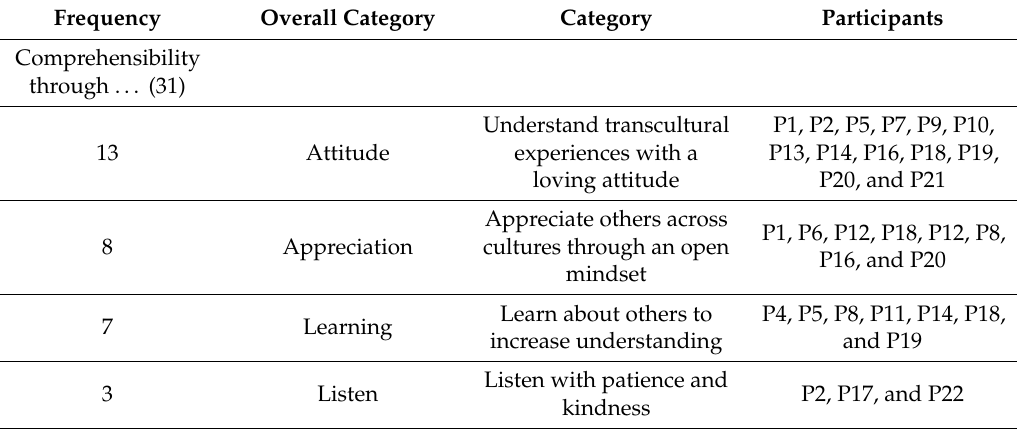
Table 2. Comprehensibility and love.